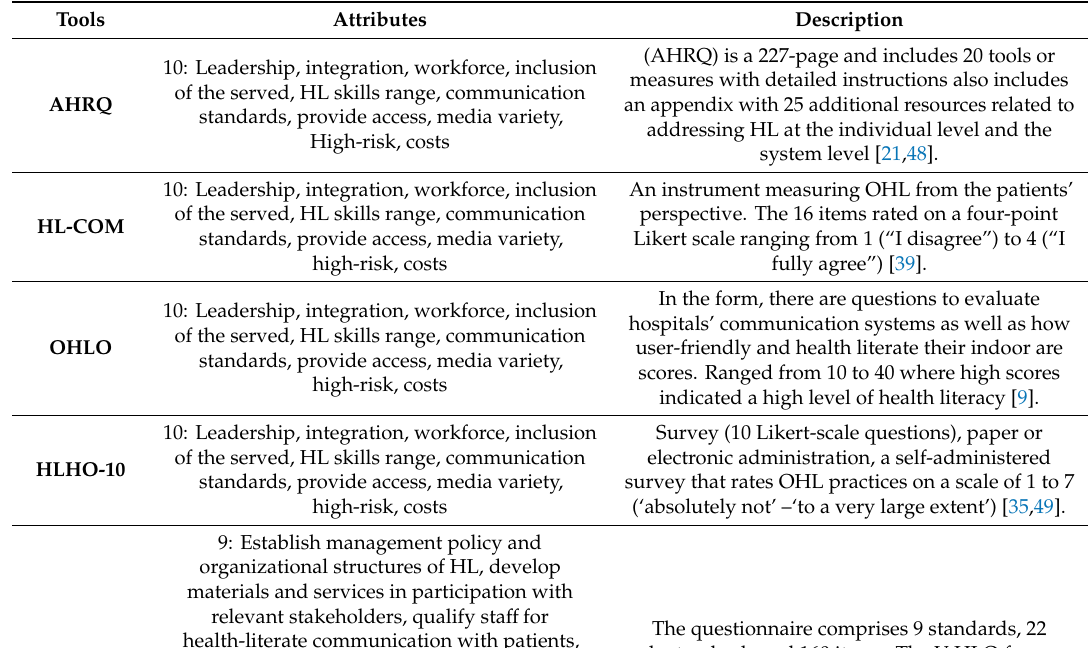
Table 3. Characteristics of the Organizational Health Literacy (OHL) Self-Assessment